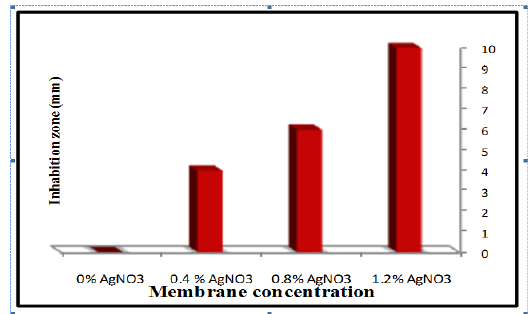
Fig. 12. Effect of (AgNO of (Nylon 6) by measuring an inhibition Zone E.Coli